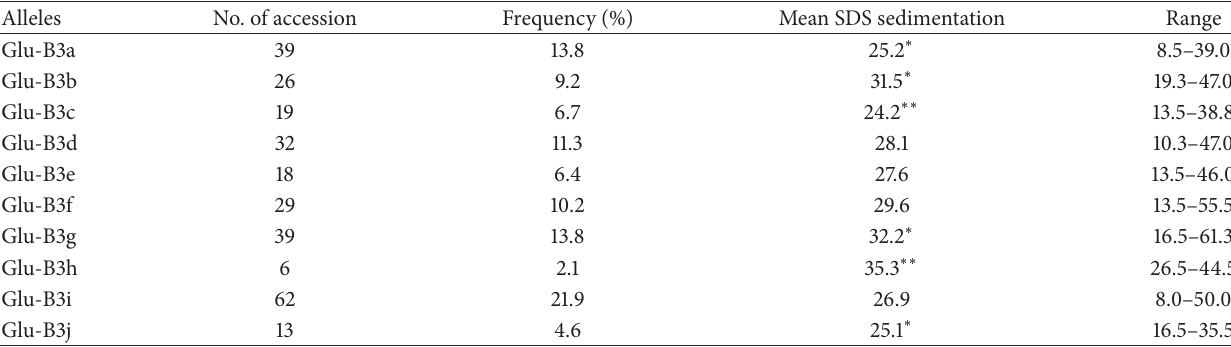
Table 1: The Glu-B3 alleles and SDS-sedimentation volume.